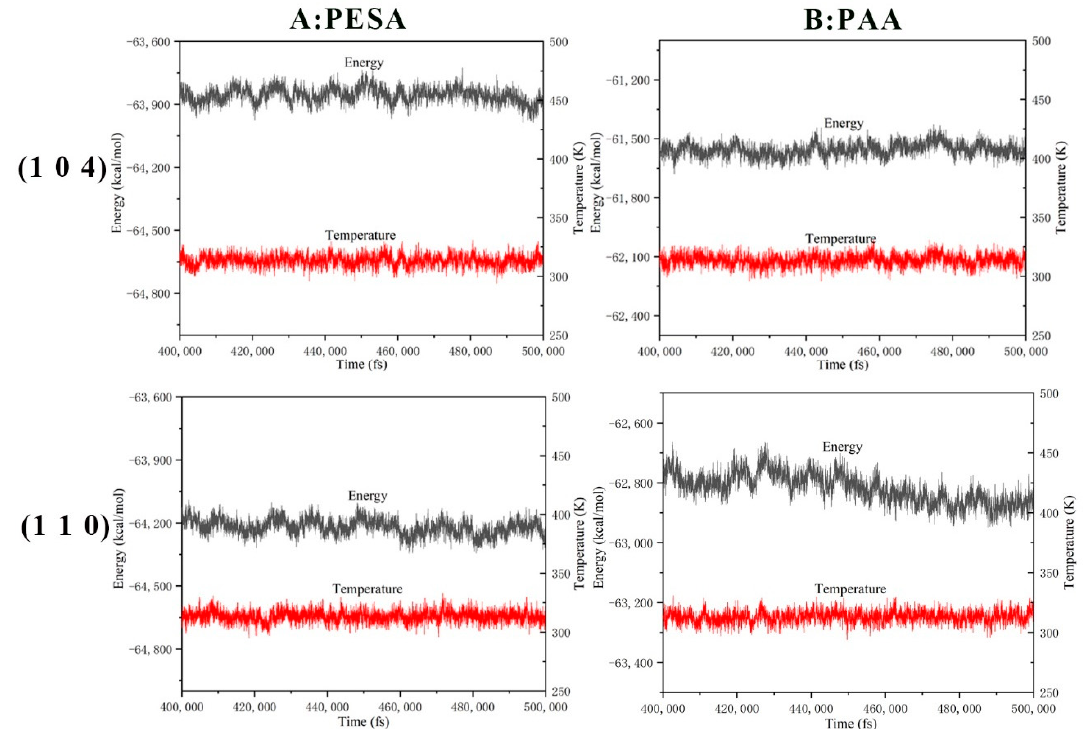
Figure 5. Fluctuations of energy and temperature during the final 100 ps of molecular simulation, ( A ) PESA; ( B ) PAA.